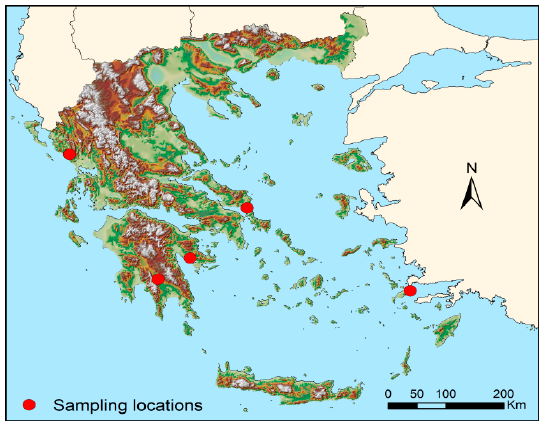
Figure 1. The sampling locations.